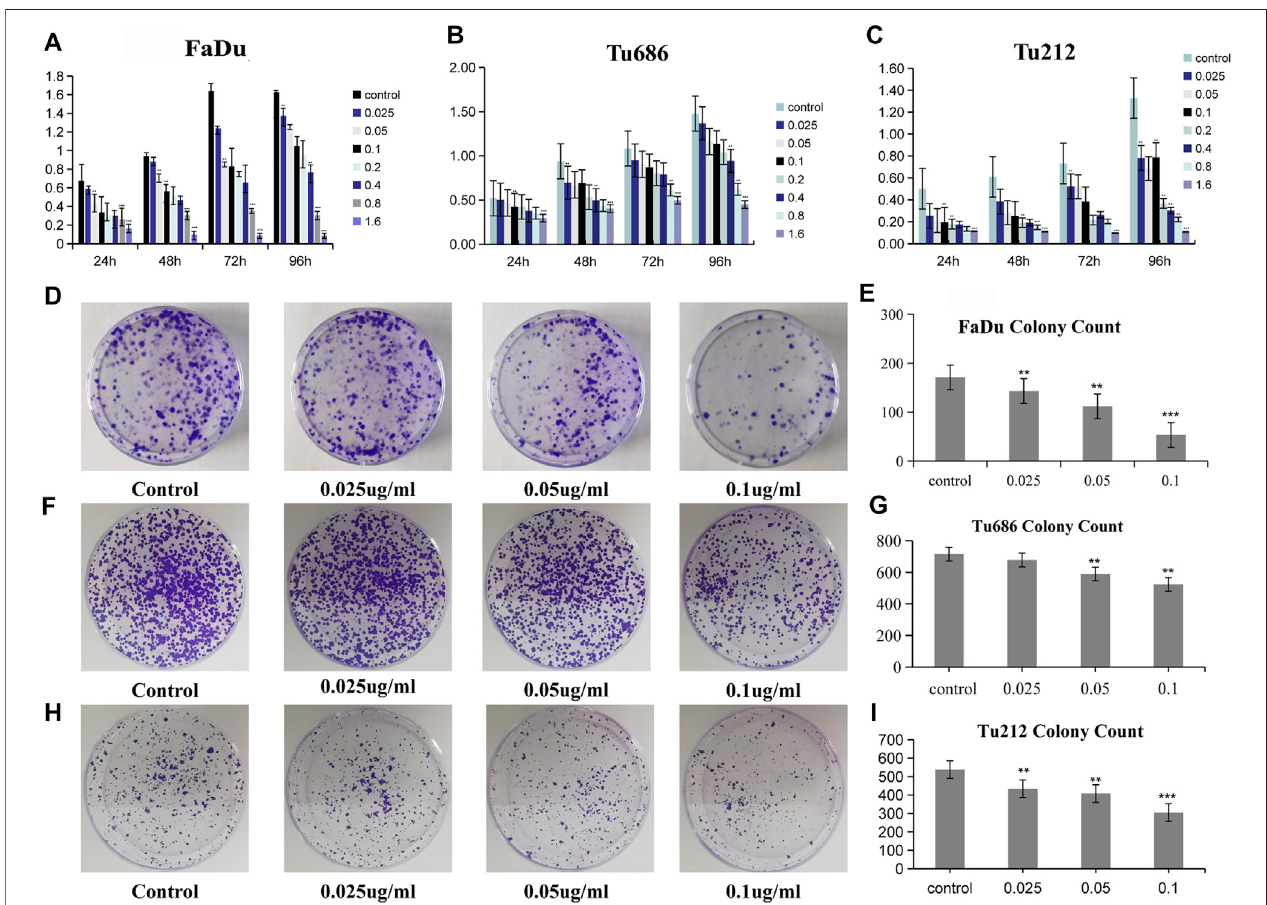
FIGURE 2 | PSII reduced the viability of HNSCC cell. (A) The inhibitory effect of PSII on FaDu cell viability by MTT. (B) The inhibitory effect of PSII on Tu686 cell viabilitybyMTT. (C) TheinhibitoryeffectofPSIIonTu212cellviabilitybyMTT. (D) FaDucellsformedcolonies. (E) Thestatistical fi gureofFaDucellscloneformationassay. (F) Tu686 cells formed colonies. (G) The statistical fi gure of Tu686 clone formation assay. (H) Tu212 cells formed colonies. (I) The statistical fi gure of Tu212 clone formation assay. Bars, 50 µm. All the experiments were carried out three times. The bar graphs and the table show quanti fi cation of the results, and each data represent the mean ± SD of three independent experiments (* p < 0.05; ** p < 0.01; *** p < 0.001 vs the control group).